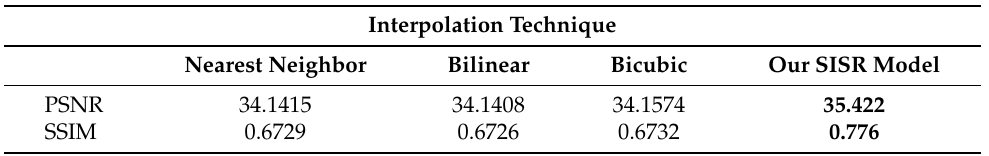
Table 4. Results on the test set of baseline interpolation techniques and our best performing model ( v 4 with Pixel-Shuffle, SISR branch). Best values in bold. Interpolation Technique Nearest Neighbor Bilinear Bicubic Our SISR Model PSNR 34.1415